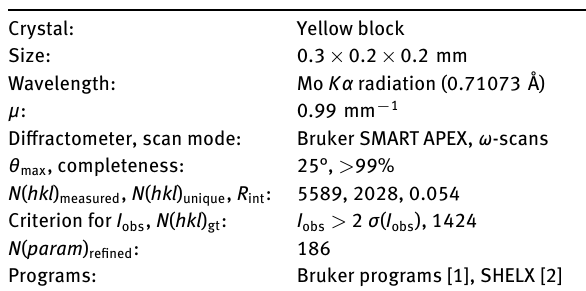
Table 1: Data collection and handling.